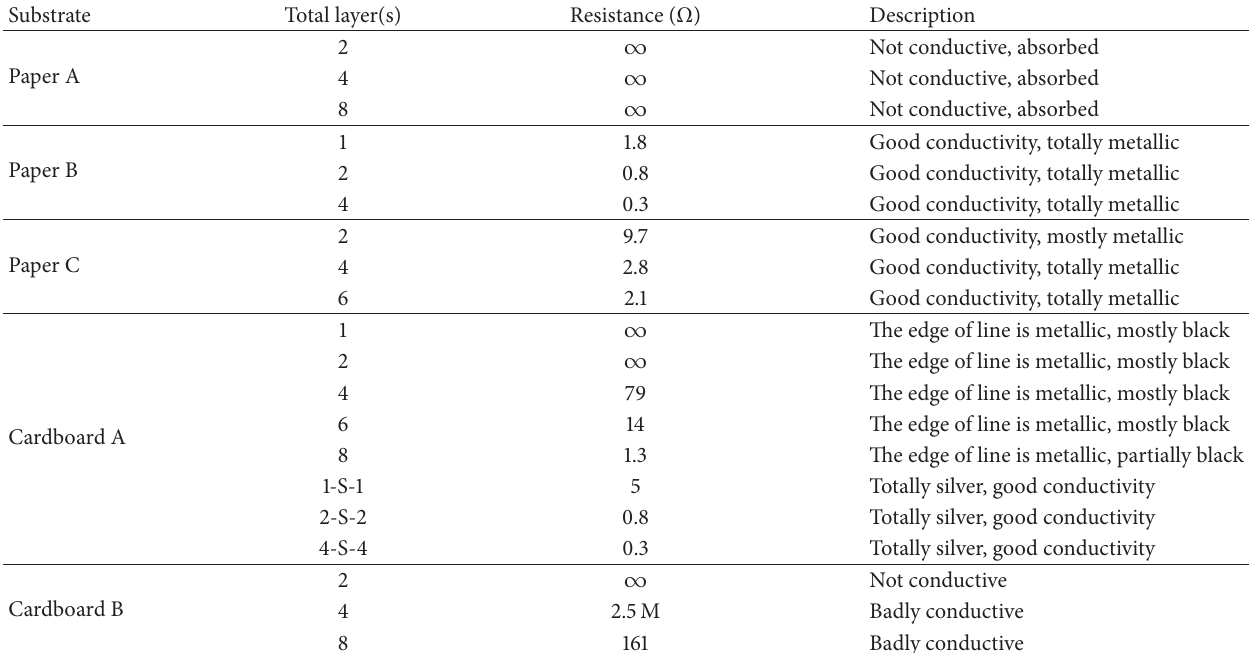
Table 5: Resistances of printed lines on all substrates.